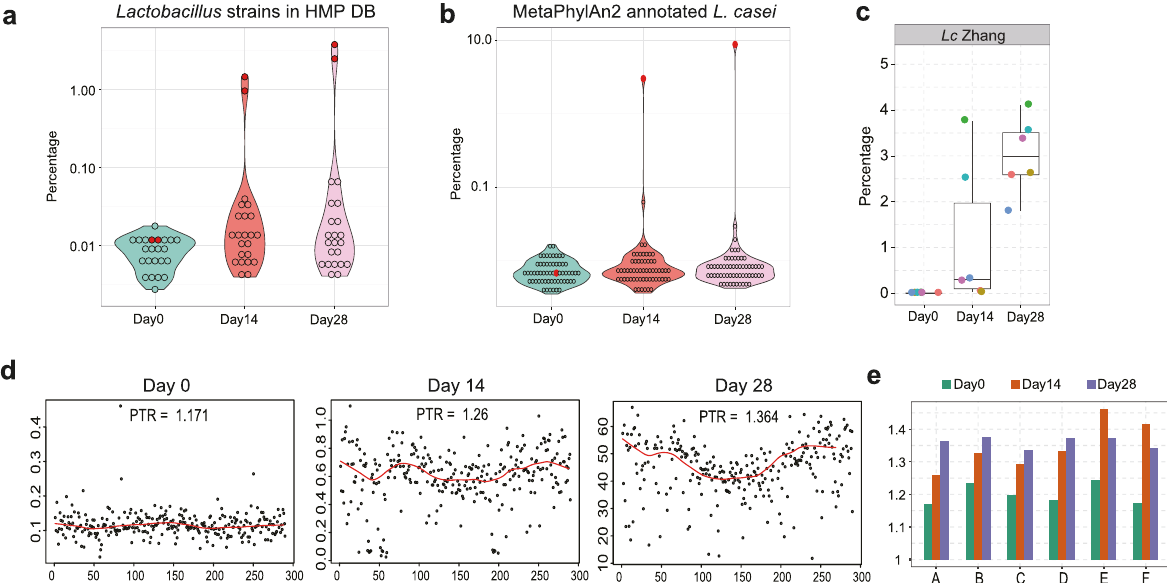
Fig. 1 The increasing replication of L. casei Zhang in the human gut. a Violin plot of total TPM for 23 Lactobacillus strains in HMP database for meta-genomic reads. Each dot represents the sum fraction of six samples in one time-point. The two red dots represent the two L. casei strains in HMP database. b Violin plot of MetaPhylAn2 mapping of meta-genomic reads. The red dot represented L. casei . c Box plot of the mapping percentages of meta-genomic reads to the L. casei Zhang. d Example of genome coverage and PTR values for A volunteer. X -axis represents the genomic location by 10 kb, and Y -axis represents the genomic coverage. The black points represent the coverage in each location, and the red lines represent the fi tting curve for the points. e Barplot of the PTR values in each stage and each